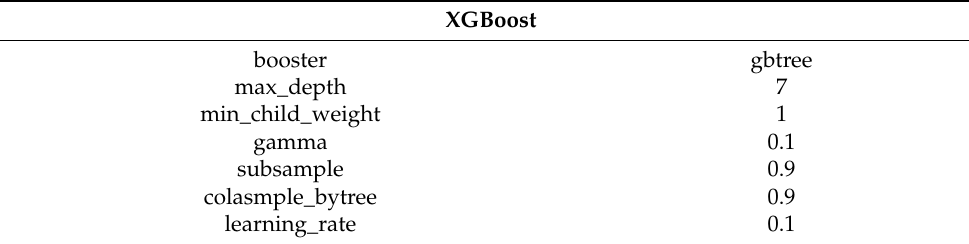
Table 2. The key parameters of the extreme gradient boosting